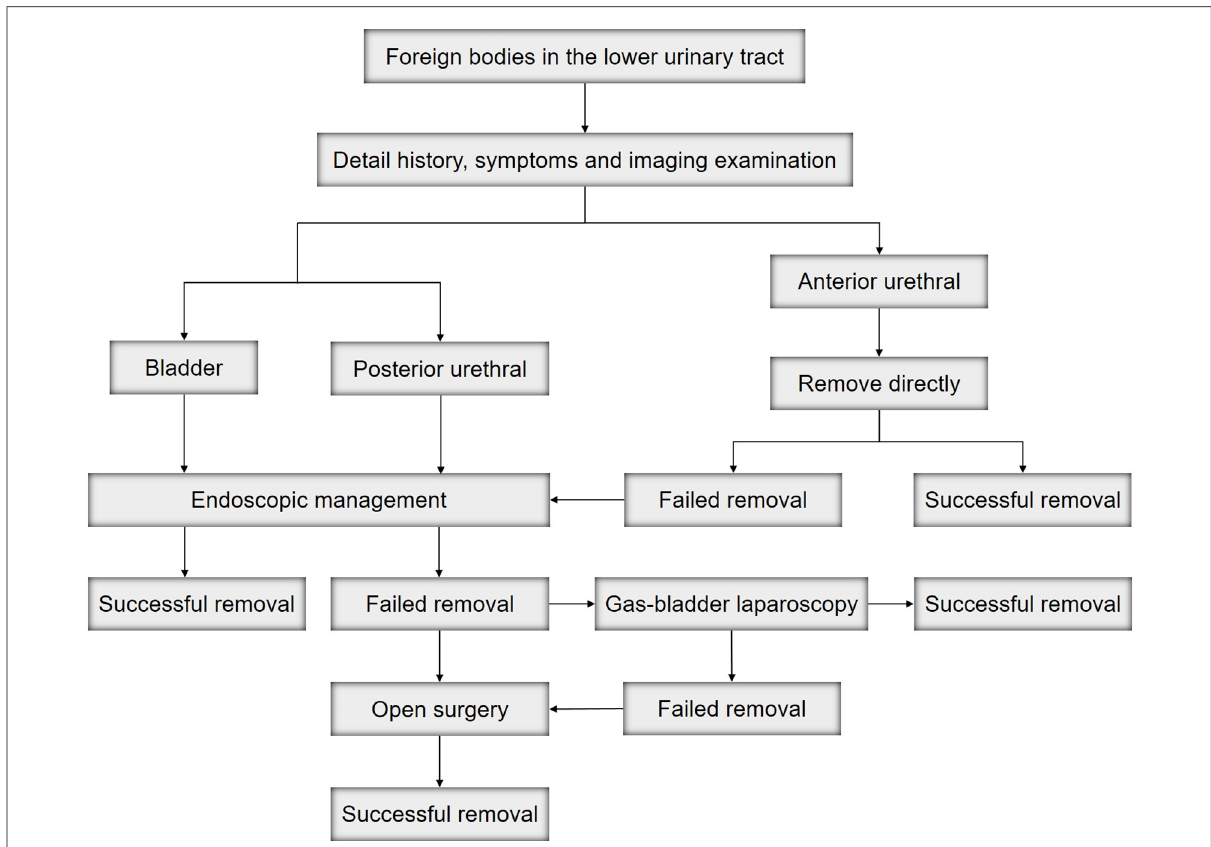
FIGURE 5 Algorithm for management of FBs in the lower urinary tract in pediatric